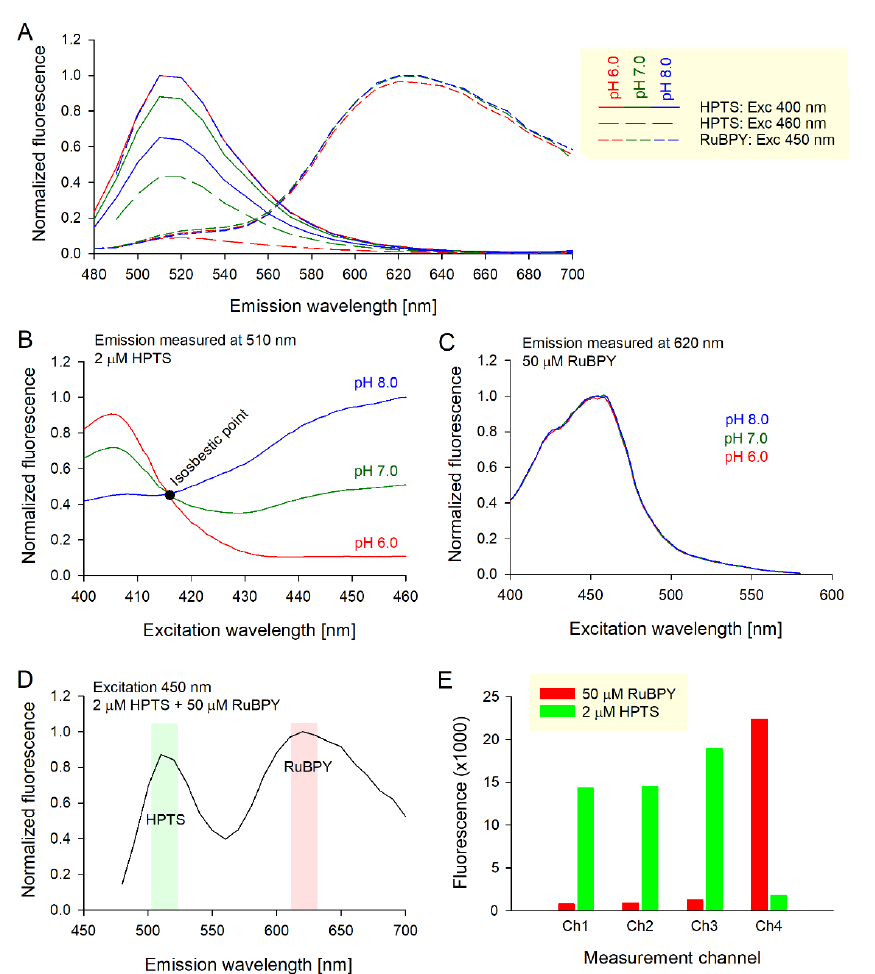
Figure 1. Spectral analyses of HPTS and RuBPY. ( A ) Emission spectra for HPTS and RuBPY measured separately in DMEM-based media buffered with 10 mM HEPES/10 mM MES and titrated to either pH 6.0, 7.0, or 8.0. ( B ) The excitation spectrum for HPTS fluorescence collected at its optimal emission (510 nm). Isosbestic point is the wavelength at which fluorescence is pH-insensitive. ( C ) The excitation spectrum for RuBPY fluorescence collected at its optimal emission (620 nm). Note the pH insensitivity. ( D ) Concentrations of HTPS (2 µM) and RuBPY (50 µM) determined empirically in DMEM-based media to produce comparable emission peaks when excited at 450 nm. ( E ) Test for fluorescence bleed-through between recording channels. Media contained either HTPS (2 µM) or RuBPY (50 µM) at pH 7.3, and measurement protocols were performed to obtain signals across all four channels sequentially (Ch1 – Ch4). Ch1 – Ch3 are nominally HPTS channels and found to detect a predominantly HPTS-emitted signal. Ch4 is nominally a RuBPY channel and detects a predomi- nantly RuBPY-emitted signal.